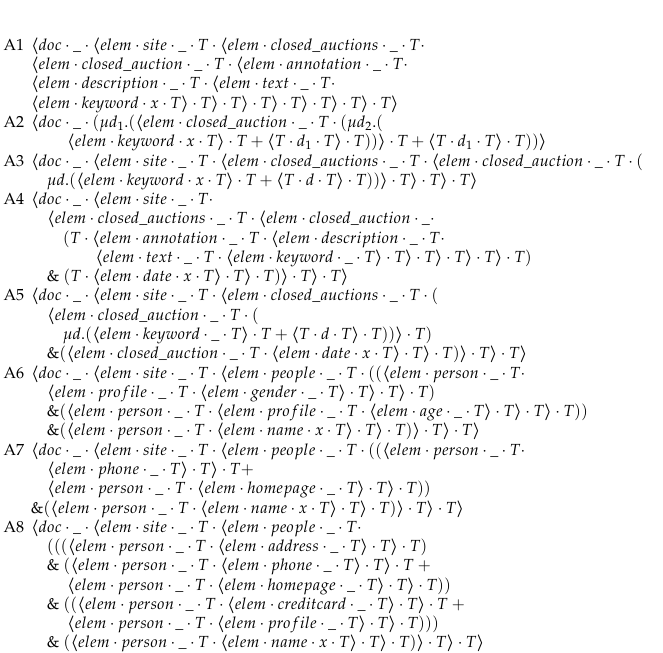
Figure A1. The NREs of the XPath benchmark